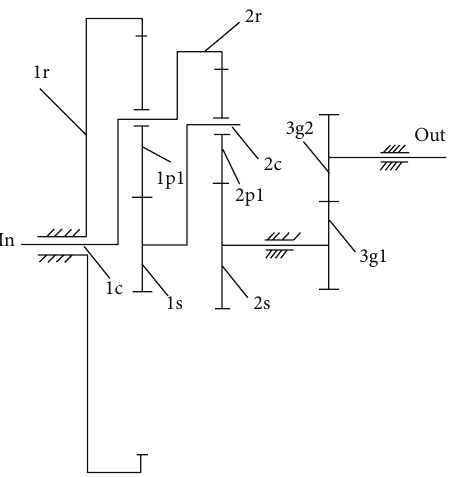
Figure 3: Transmission system of load-split multiple-stage plane- tary gear